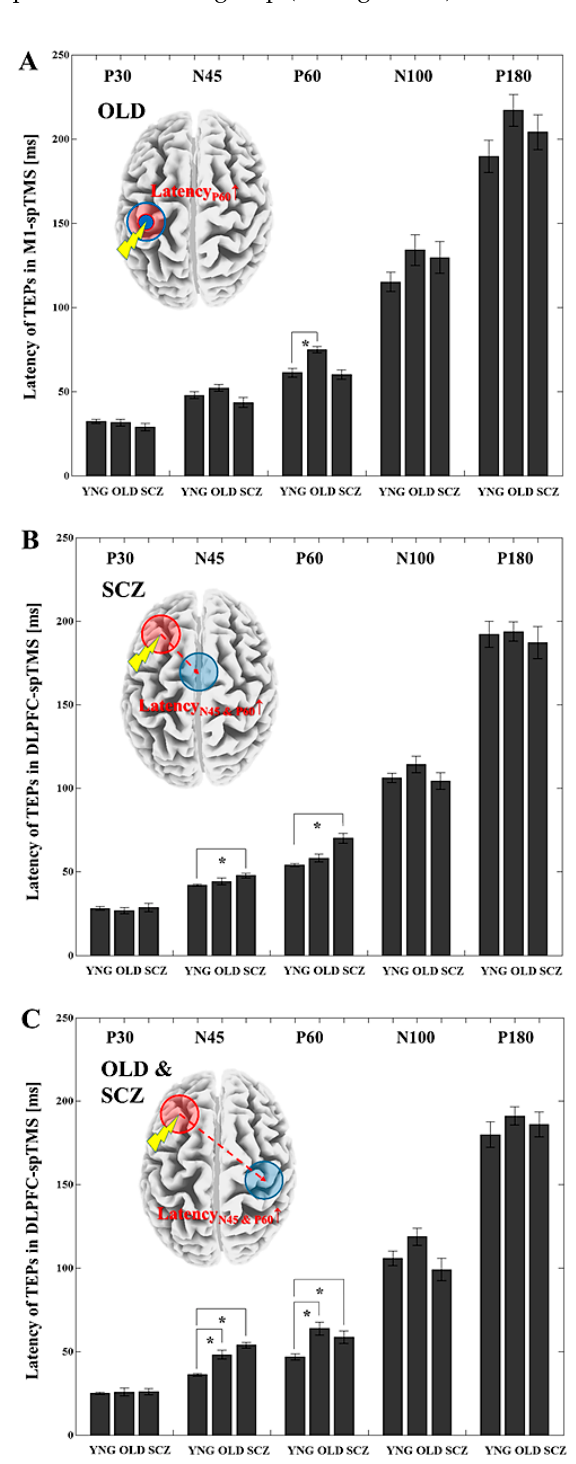
Figure 3. Latency differences for each TEP component among healthy young (YNG) participants, older (OLD) participants, and patients with schizophrenia (SCZ). TEP latency differences among groups at the LC ROI (left M1) induced by